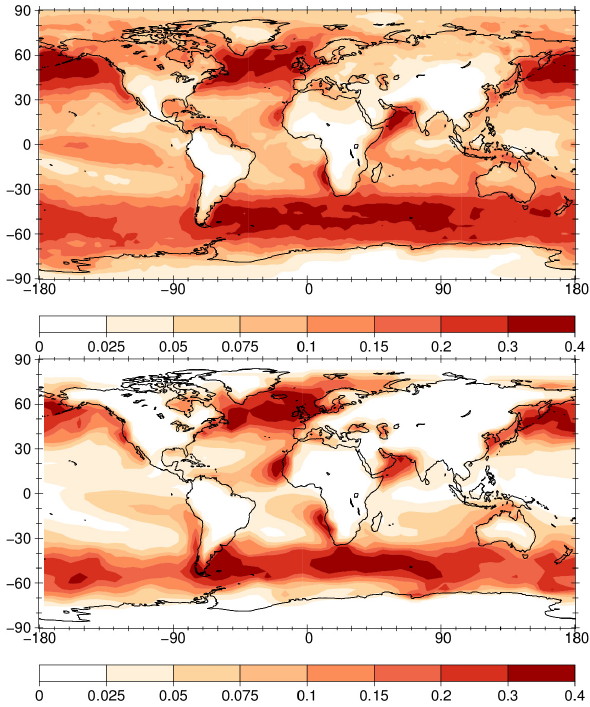
Fig. 3. Annual mean mass density of accumulation mode sea spray particulate organic mass (POM = 1.8 · POC, µgm − 3 ) in the model surface layer. (A) Simulation based on MODIS-Aqua POC seasonal climatology (this work). (B) Modelled water-insoluble organic mass from primary sea spray emissions in the TM5 model (Vignati et al., 2010). Differences in the distributions result from differences in emissions, but also in loss processes and other model components.